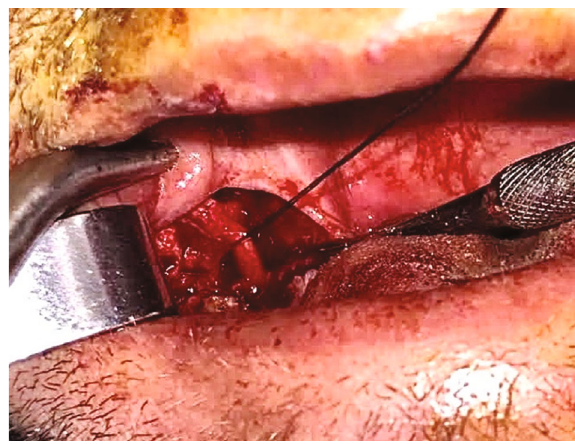
Figure 3: Dissected lingual nerve.